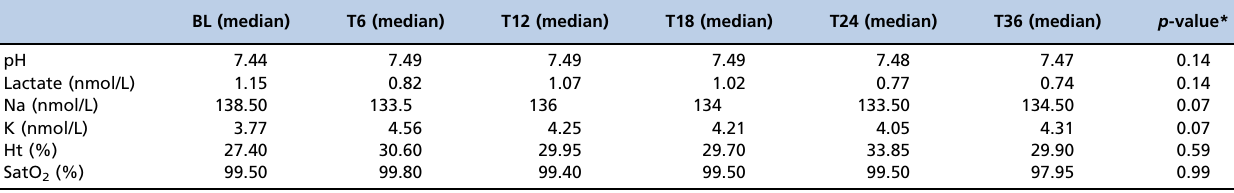
PDS: Peritoneal dialysis solution; MAP: Mean blood pressure; HR: Heart rate; IAP: intra-abdominal pressure; CO: Cardiac output; * Paired Wilcoxon test (T0XT36). Table 3 - Biochemical variables of animals submitted to peritoneal lavage with